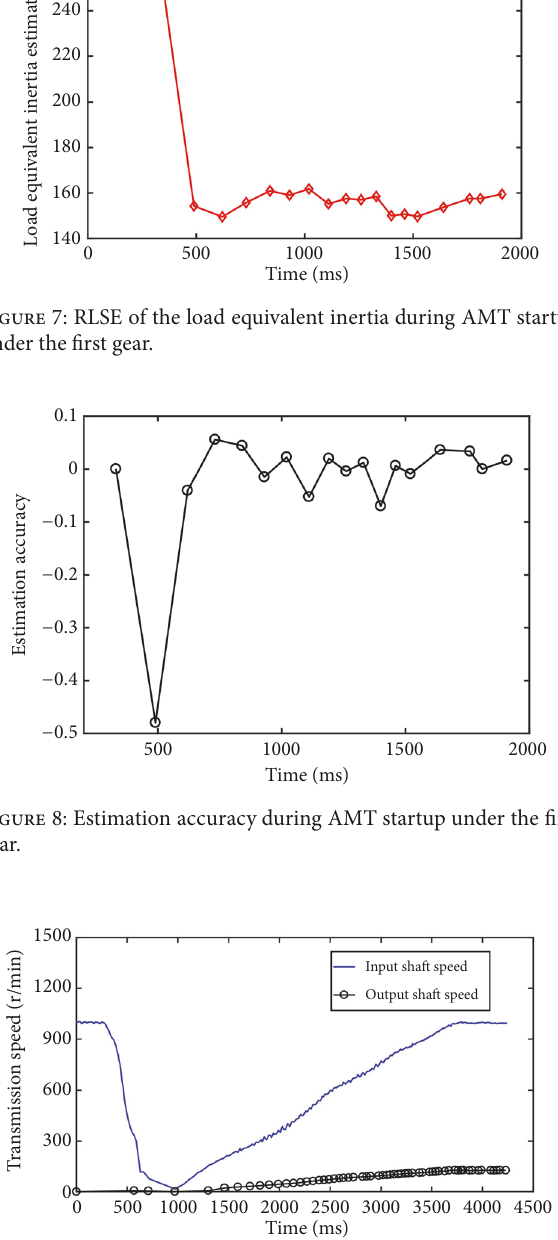
Figure9:Thetransmissionspeedsduringthestartingprocessunder the third